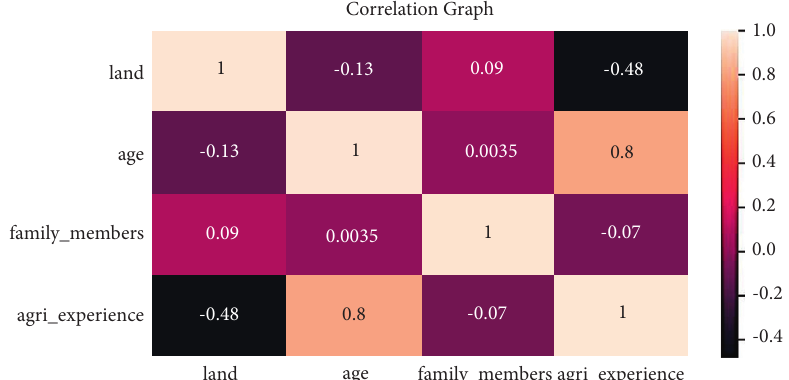
Figure 17: Correlation graph of land with different parameters.